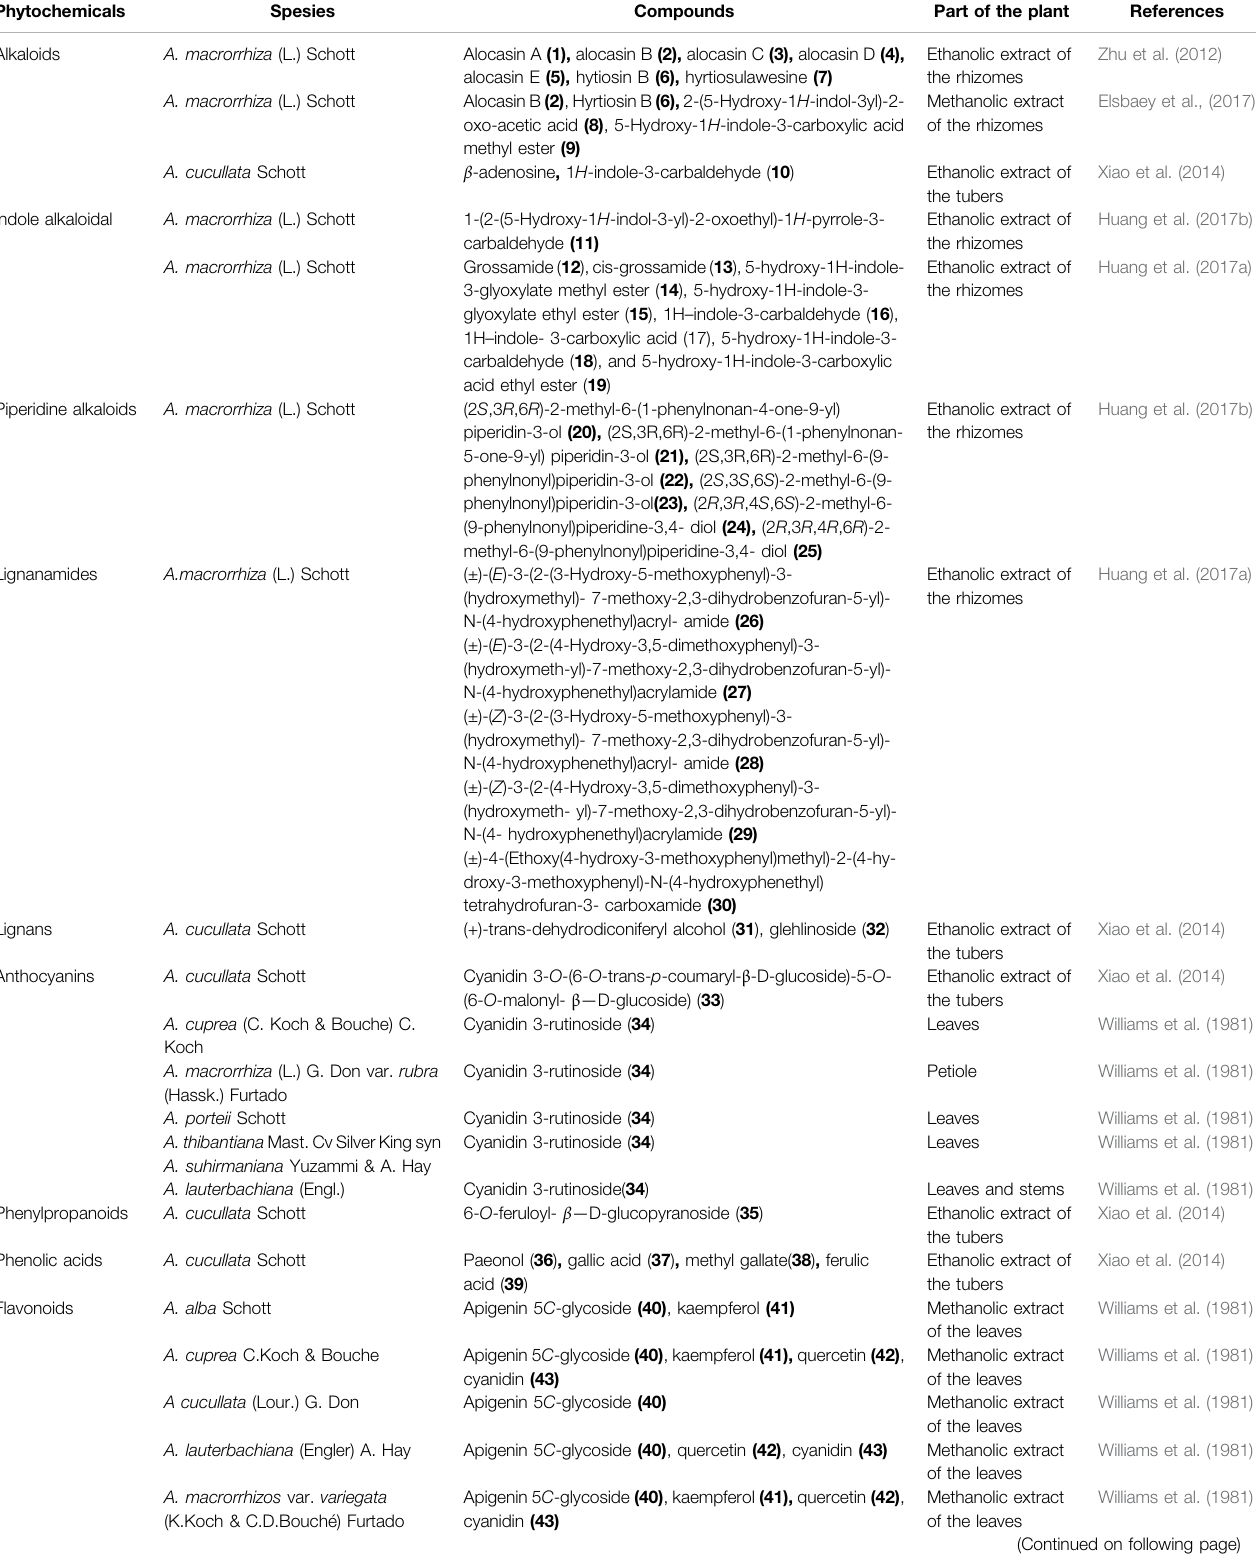
TABLE 3 | Summary phytochemicals and part used of some Alocasia